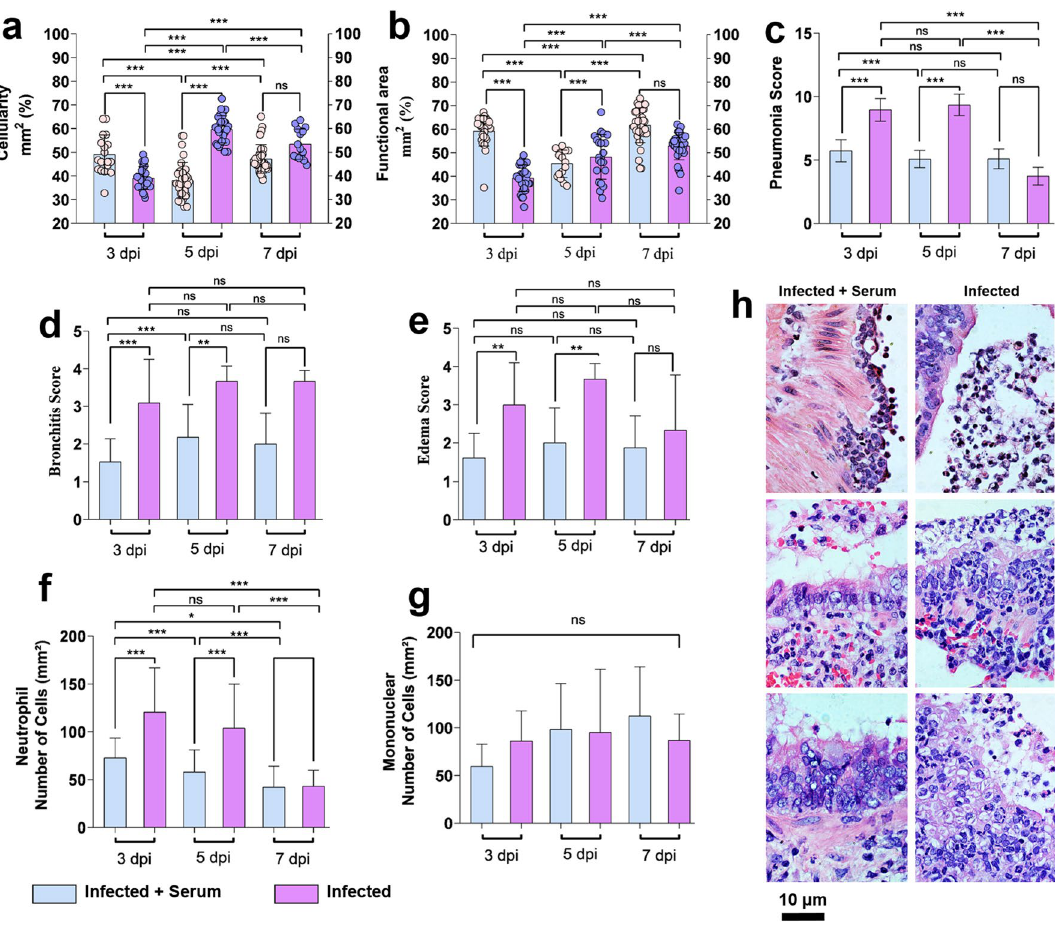
Figure 5. Histopathological changes in hamsters infected and treated with equine anti-SARS-CoV-2 F(ab ′ ) 2 immunoglobulin. Cellularity ( a ), functional lung area ( b ), pneumonia ( c ), edema ( d ) and bronchitis ( e ) scores. Infiltration kinetics of leukocytes ( f ), neutrophils, and ( g ) mononuclear cells. Evolution of lesions in the bronchial epithelium ( h ). Data are presented as the means ± standard deviations of samples of six animals per group for the scores and five fields/images per slide. The data were analysed statistically with one-way ANOVA, followed by Tukey’s post-test. ***p < 0.0001; ** p < 0.001. Bar 10 µm; haematoxylin and eosin staining F(ab ′ ) 2 IgG presented lower concentration per vial than the maximum value specified by the national Pharma- copeia, thus assuring that quantity added is far from the potential toxic limit. Although differences in potency were observed, the product was able to neutralize three SARS-CoV-2 variants in vitro, similar to results obtained for several tests used to establish vaccine efficacy in humans against each new virus variant 30,31 . Preclinical safety studies performed according to the guidelines of the Brazilian Regulatory Agency using mice and rabbits did not show any toxic effect of the equine anti-SARS-CoV-2 F(ab ′ ) 2 immunoglobulin (data not shown). Golden Syrian hamsters were used for the preclinical evaluation of the protective efficacy of anti-SARS-CoV-2 equine serum. An analysis of the viral load in the lung measured using qRT-PCR 3 days after infection showed a significant difference (p < 0.05) between the animals treated with and without the antiserum. Nonetheless, no significant difference in the viral load in trachea and nasal turbinates was observed between groups, as measured using qRT-PCR and by determining the TCID 50 . Importantly, the challenge studies were conducted using a single antiserum dosage, which was planned to be a lower dose relative to the body weight of a human subject that could be injected. This dosage may explain the lack of a noticeable reduction in viral load, as in vitro studies showed that the serum batches have high potency for neutralization. Nonetheless, anti-SARS-CoV-2 equine antibodies were already detected in the lung 24 h after serum administration (Day 3 p.i.), when nonendogenous anti-SARS-CoV-2 hamster antibodies were present and in which a significant difference in the viral load was determined in the lung. These data reinforce the protective role of the anti-SARS-CoV-2 F(ab ′ ) 2 immunoglobulins in controlling COVID-19 in the hamster model. On Days 5 and 7 p.i., hamster neutralizing antibodies were present, as along with decreased levels of equine antibodies. The histopathological analysis showed that equine serum treatment administered 48 h after SARS-CoV-2 infection impaired disease development in hamsters, significantly reducing oedema and neutrophil infiltration into the lung. These data support the potential benefits of this treatment for human patients, who generally suffer from COVID-19-triggered inflammation and the formation of neutrophil extracellular traps 32 . The distribution